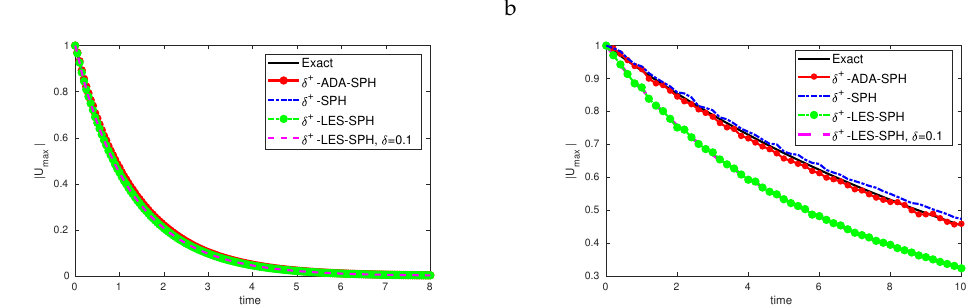
Figure 3. Two-dimensional Taylor–Green flow. Decay of the maximum velocity for Re = 100 ( a ) and Re = 1000 ( b ). The theoretical solution is taken from